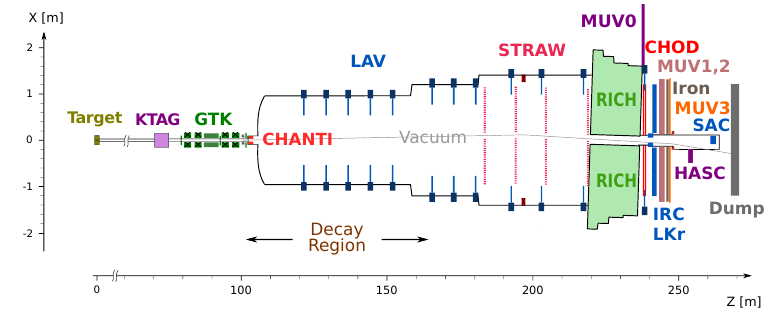
Figure 1. Schematic view of the NA62 experimental